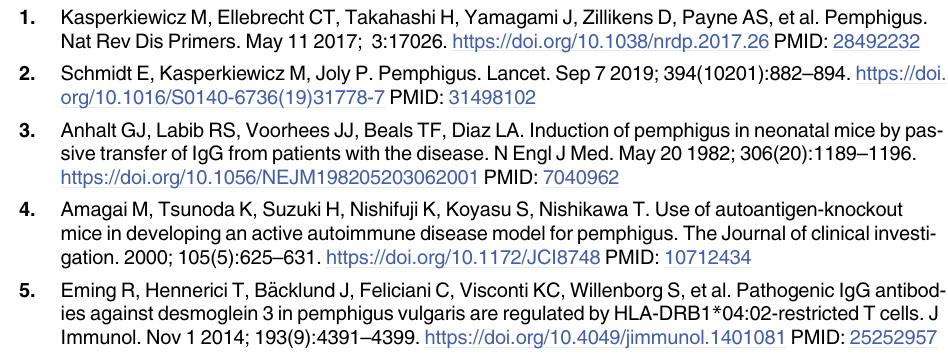
S3 Table. Adverse events score. The sum of all side adverse effects was added to a total sum. S4 Table. Results adverse event score. The mean and standard deviation (SD) of the adverse effects of the experiments is summarized in here. Immunizations did not increase the burden of mice during as the adverse events score is not significantly